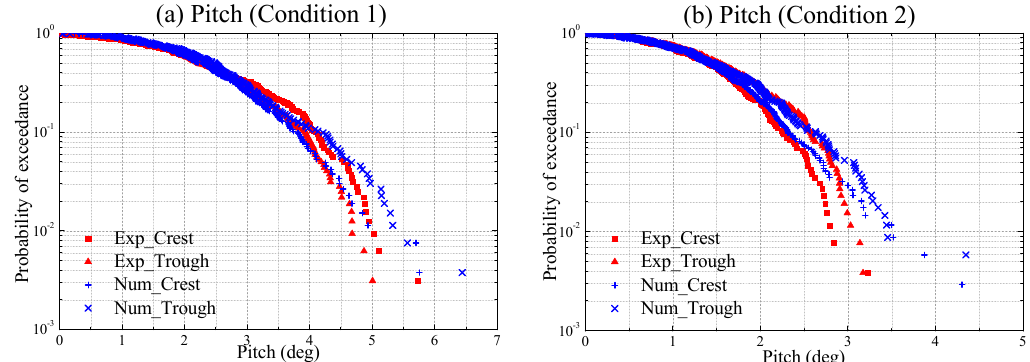
Figure 11. Comparison of probability of exceedance of pitch motion.